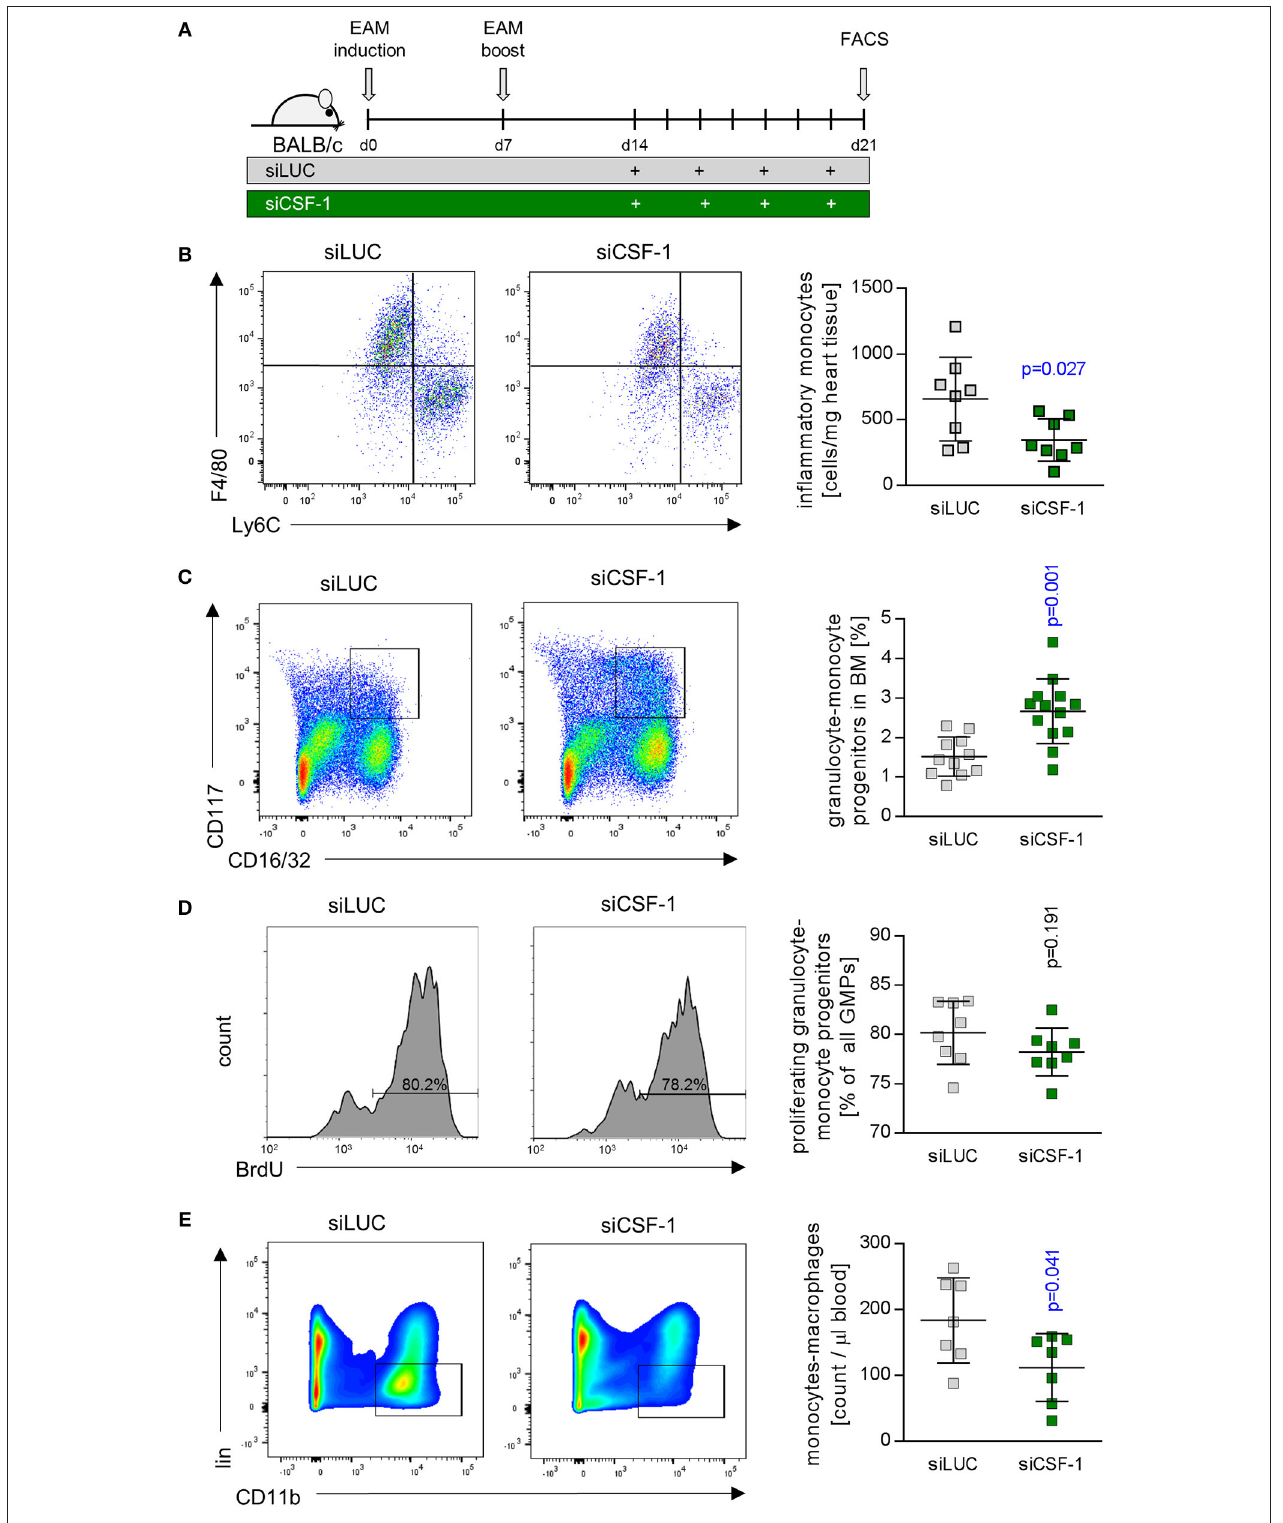
FIGURE 6 | CSF-1 silencing during EAM diminishes infiltration of inflammatory monocytes into injured mouse hearts. (A) EAM was induced by inoculation of myosin peptide in conjunction with Freud’s adjuvant and mice were boosted after 7 days. Nanoparticle-encapsulated CSF-1 siRNA #7 ( Figure 3 ) was investigated